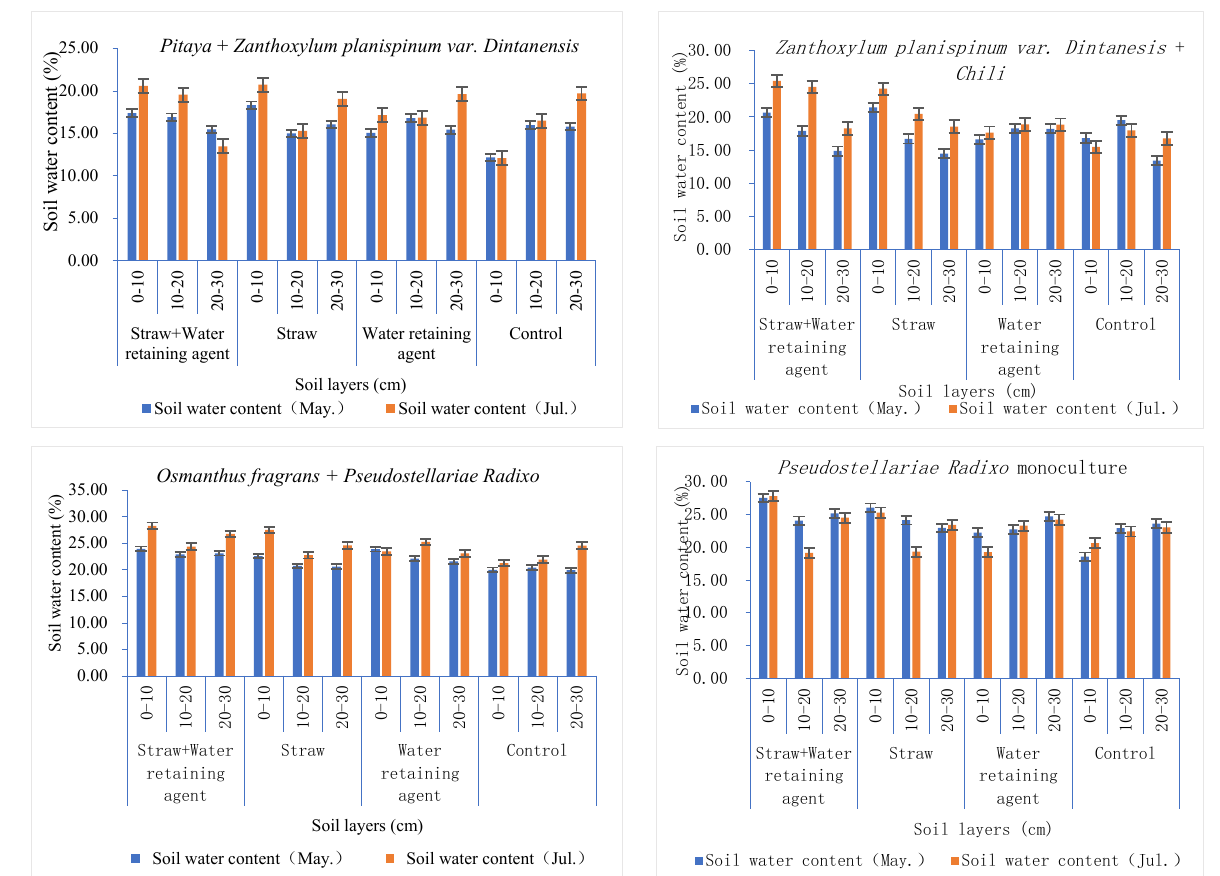
Figure 2. Soil water content under each treatment.